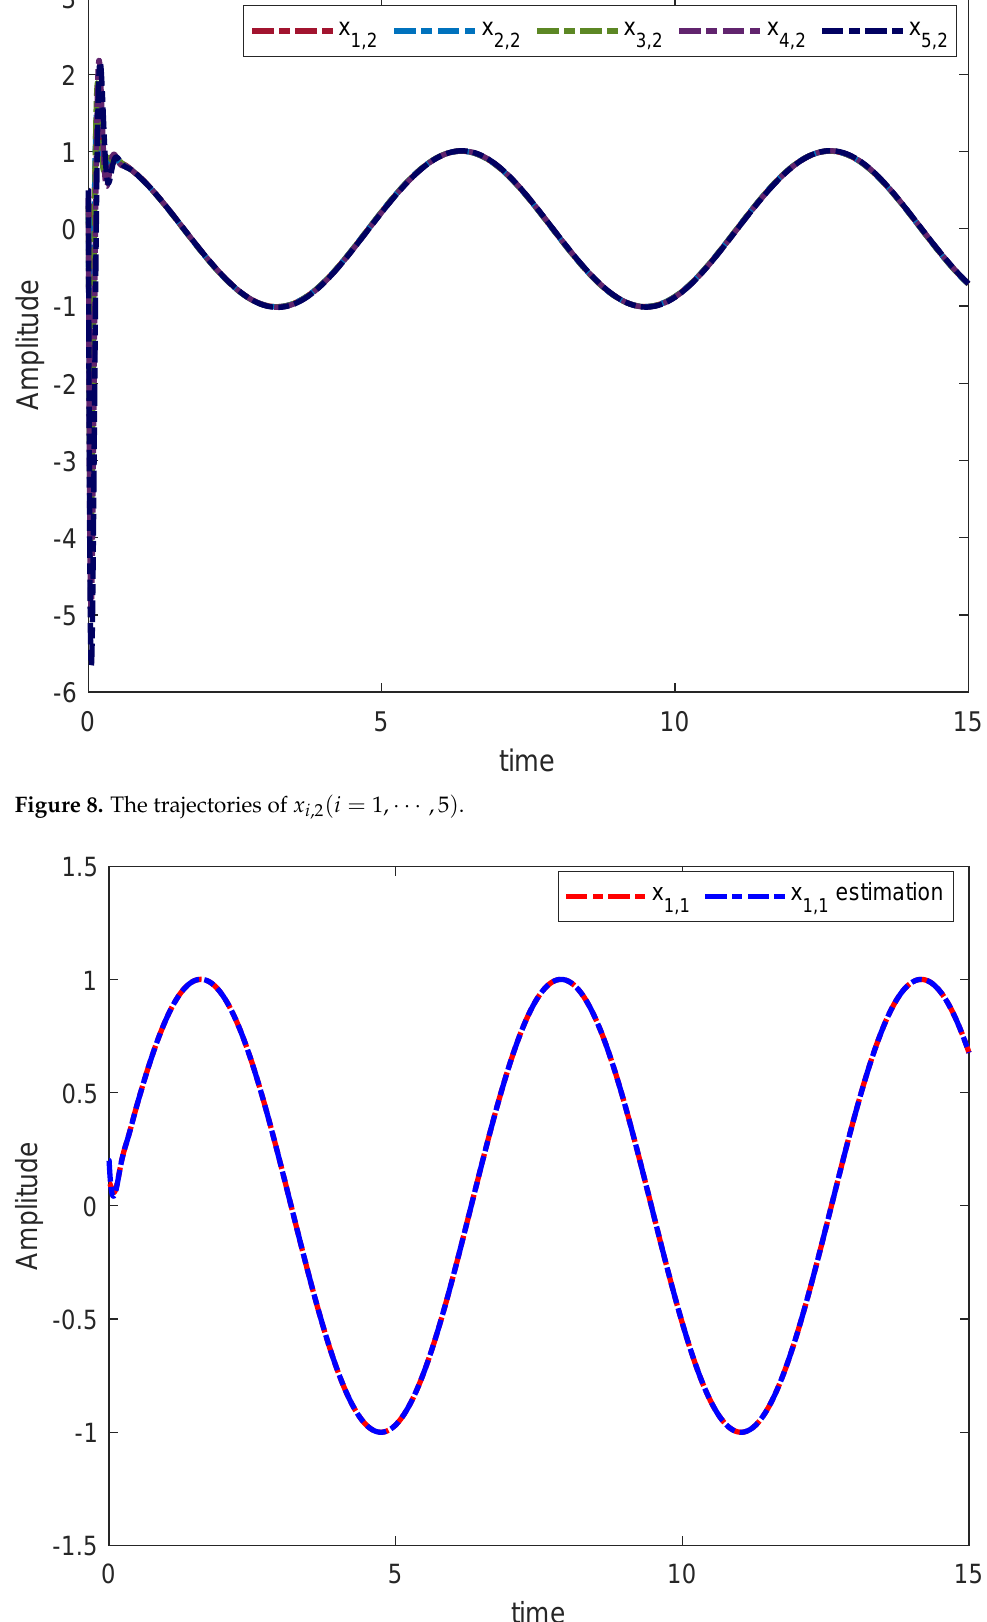
Figure 9. The trajectories of x 1,1 and its